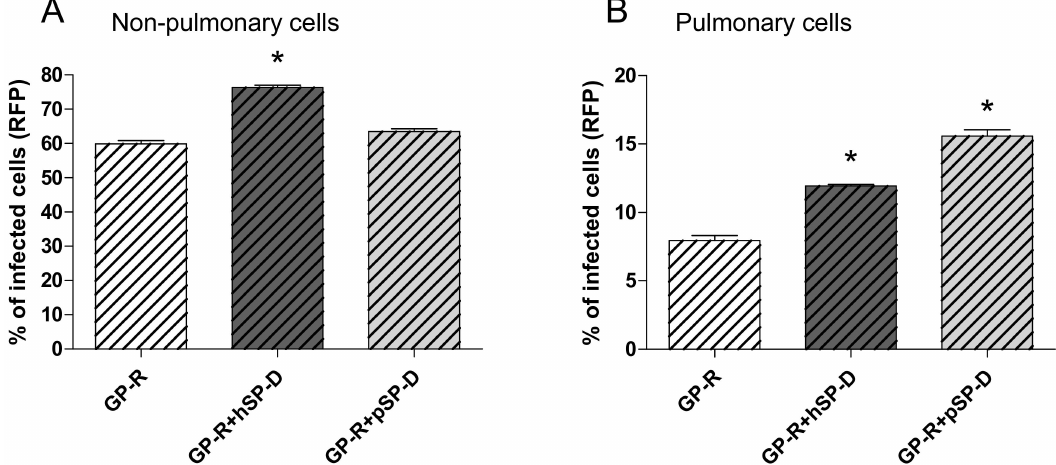
Figure 5. Transduction of non-replicative GP-R pseudoparticles in presence of hSP-D and pSP-D. rVSV-RFP-GP-R pseudoparticles were preincubated with hSP-D and pSP-D (10 µ g/mL) for 1 h at 37 ◦ C before incubation with Vero E6 cells ( A ) or A549 cells ( B ) for 1 h at 37 ◦ C. RFP level expression was analyzed using flow cytometry. The results for the preincubated groups were compared to those of non-preincubated groups. *, a statistically difference ( p < 0.05, two-tailed unaired Student’s t -test). The results shown are the mean of three (Vero E6 cells) and two (A549 cells) independent